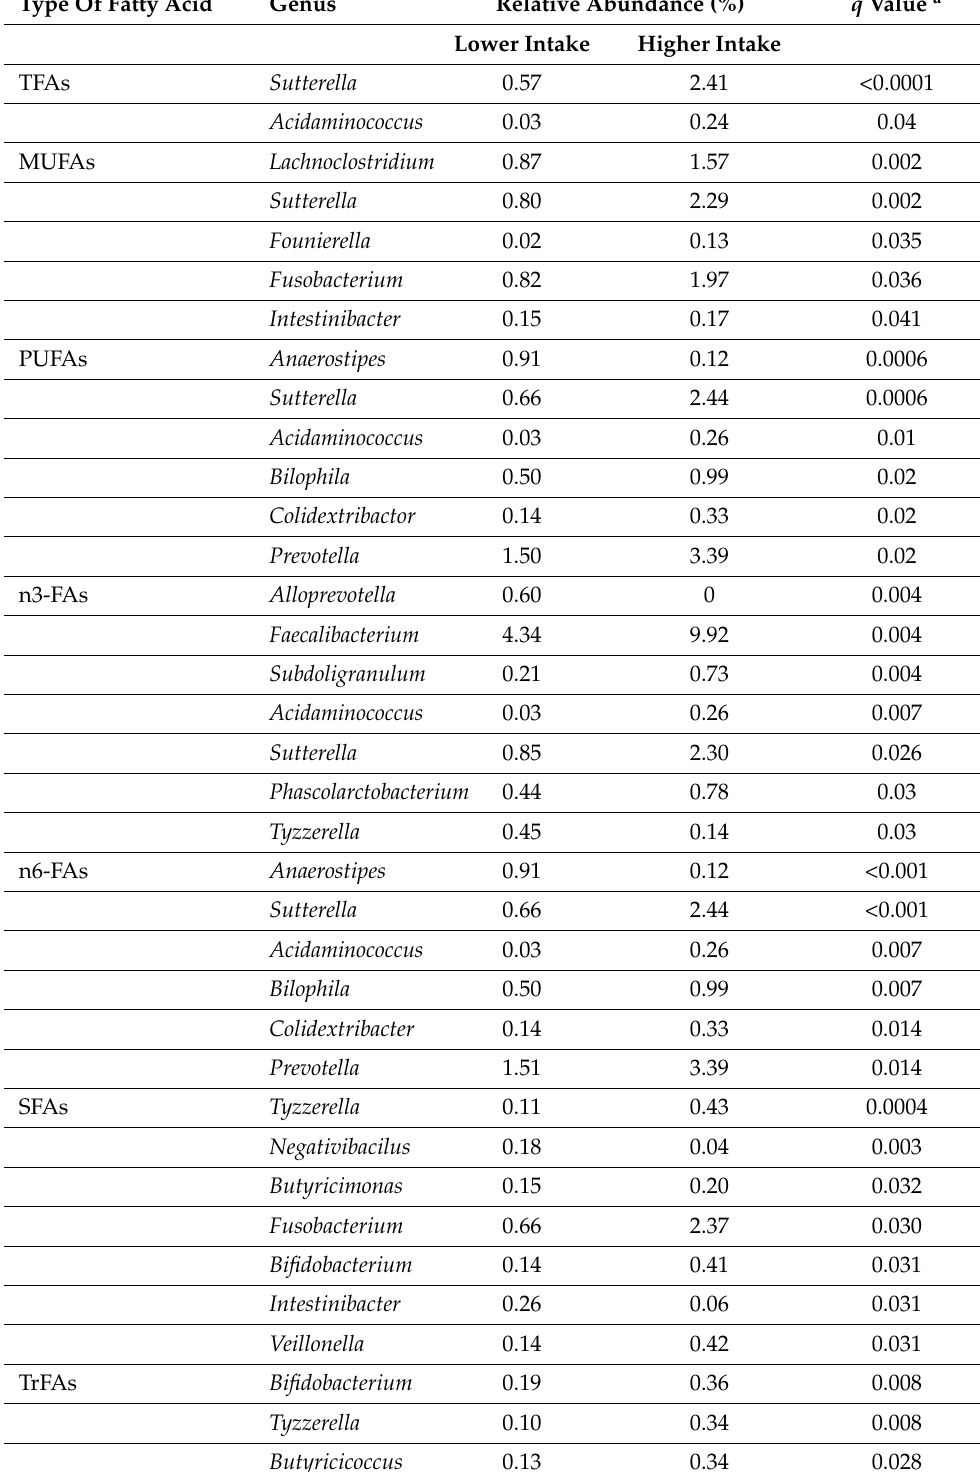
Table 3. Relative abundance of bacterial genus by fatty acid